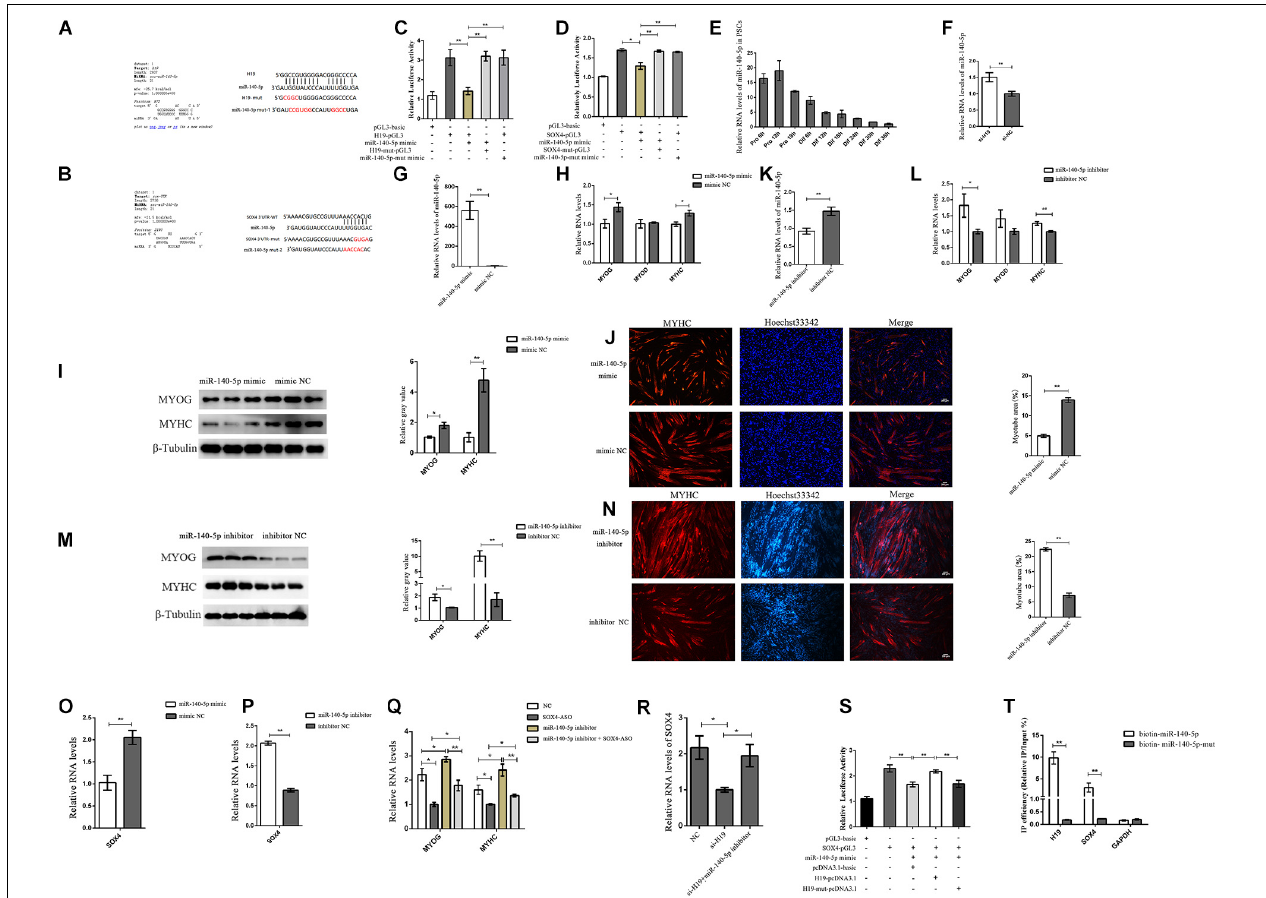
FIGURE 5 | H19 regulated SOX4 as a molecular sponge of miR-140-5p. (A) Bioinformatics prediction of miR-140-5p as a target miRNA of H19 by RNAhybrid. (B) Bioinformatics predicted a miR-140-5p binding site in SOX4. (C) Luciferase reporter assay of H19-pGL3 and H19-mut-pGL3 in PSCs transfected with either miR-140-5p mimic or miR-140-5p-mut mimic. (D) Luciferase reporter assay of SOX4-pGL3 and SOX4-mut-pGL3 in PSCs transfected with either miR-140-5p mimic or miR-140-5p-mut mimic. (E) Real-time PCR analysis of miR-140-5p expression in PSCs during the period of proliferation and differentiation. There is a 6-h interval between each period. Mean values ± SEM, n = 3. (F) Real-time PCR analysis of miR-140-5p expression in PSCs transfected with H19 siRNA or negative control. (G–I) Overexpression of miR-140-5p inhibited the expression of MYOG and MYHC. (J) Representative photographs of MYHC immunofluorescence staining in PSCs differentiated for 24 h showing that miR-140-5p overexpression significantly decreased the MYHC expression level. (K–M) miR-140-5p inhibitor increased MYOG and MYHC level. (N) Representative photographs of MYHC immunofluorescence staining in PSCs differentiated for 24 h showing that miR-140-5p inhibitor significantly increased the MYHC expression level. (O) miR-140-5p overexpression decreased expression of the SOX4. (P) miR-140-5p inhibitor increased expression of the SOX4. (Q) Real-time PCR analysis of expression of MYOG and MYHC in PSCs after transfection with SOX4 ASO, miR-140-5p inhibitor, and a combination of the two. (R) Real-time PCR analysis of expression of SOX4 in PSCs after transfection with H19 siRNA or with H19 siRNA and miR-140-5p inhibitor. (S) Luciferase reporter assay of SOX4-pGL3 in PK cells transfected with miR-140-5p mimic, H19-pcDNA3.1, or H19-mut-pcDNA3.1. (T)